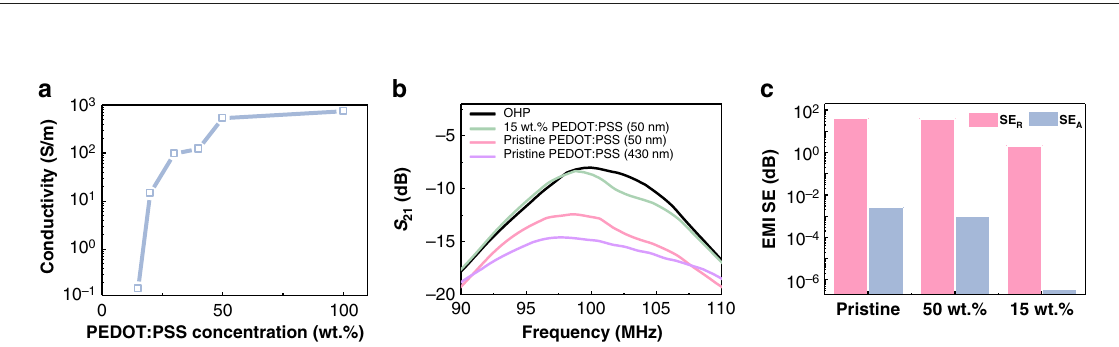
Fig. 3 Electrical and electromagnetic (EM) characteristics of poly(3,4-ethylenedioxythiophene):-poly(styrenesulfonate) (PEDOT:PSS) fi lms of different concentrations. a Electrical conductivity of electrode as a function of PEDOT:PSS concentration of solution. The inset shows a 4-point probe that measures the sheet resistance of a PEDOT:PSS fi lm. b Measured S 21 parameter of OHP/PEDOT:PSS fi lms of different thicknesses and solution concentrations over a 90 – 110-MHz frequency range. Even if a same thickness of PEDOT:PSS is coated, the EM wave transmittance can vary greatly depending on the concentration of solutions. c Calculated SE R and SE A , based on the measured conductivities and thicknesses of the PEDOT:PSS fi lms that is spin-coated at different concentrations at 100 MHz